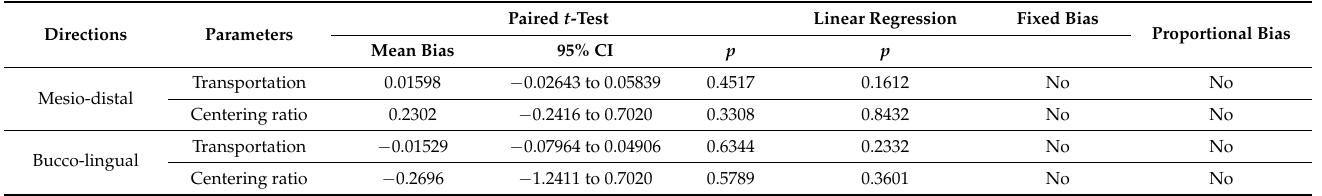
Table 3. Mean bias, confidence intervals, p values in two statistical tests, fixed or proportional bias at all five levels for the transportations and centering ratios of the two methods’ measurements in both